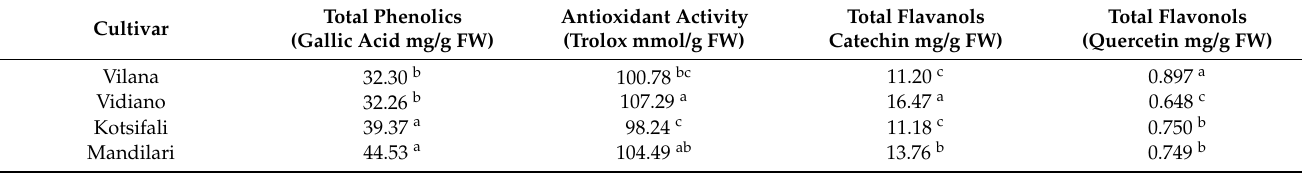
Table 3. Phenolic content, antioxidant activity, total flavanols and total flavonols content in seeds of Vilana, Vidiano, Kotsifali and Mandilari cultivars on harvest day.